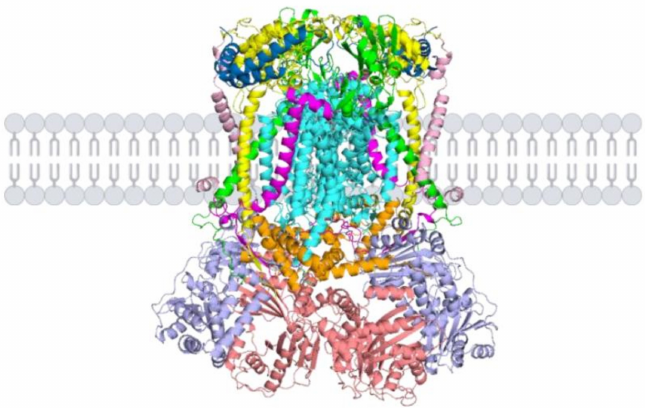
Figure 2. Structure of the homodimeric bc 1 complex in the inner mitochondrial membrane based on the crystal structure analysis carried out in yeast mitochondria (cytochrome b : aquamarine, cytochrome c 1 : yellow, ISP: green, core protein 1: light blue, core protein 2: salmon, Qcr6p: sky blue, Qcr7p: orange, Qcr8p: pink, Qcr9p: